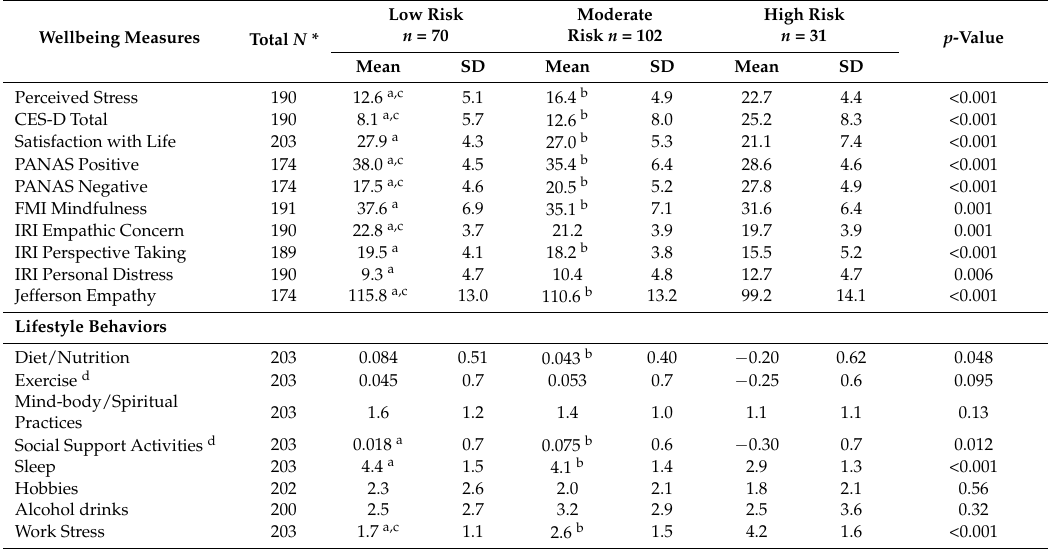
Table 4. Results of one-way variance analysis (ANOVA) for Burnout Group and wellbeing—means and standard